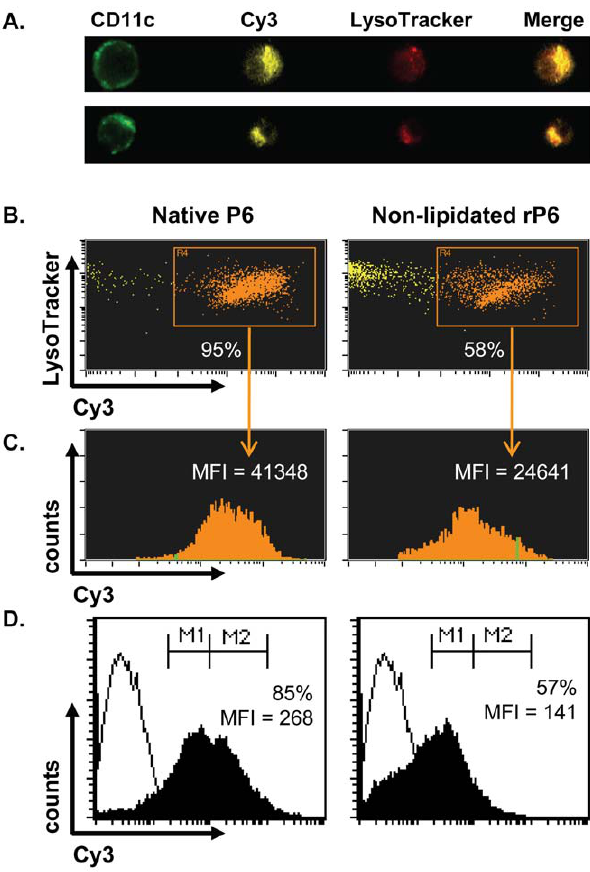
Figure 5. Enhanced endocytosis of lipid-expressing P6 by BMDCs. BMDCs from WT mice were incubated overnight with Cy3- conjugated native P6 or non-lipidated rP6. Cells were incubated with 100 m M LysoTracker Red for 30 min prior to harvest and then stained with anti-CD11c FITC. ( A ) Representative image analysis of Cy3- conjugated endocytosis andco-localization with LysoTracker forbacterial P6 (top row) and non-lipidated rP6 (bottom row). ( B ) Percent of CD11c + BMDCs that endocytosed Cy3-conjugated antigen and co-localize with LysoTracker. ( C ) Amount of endocytosed antigen present in Cy3 + cells as determined by Cy3 mean fluorescent intensity (MFI). ( D ) Antigen uptake by BMDCs determined by two-color flowcytometry (FITC vs Cy3). Percent of CD11c + cells that have endocytosed Cy3-conjugated antigen over unstimulated BMDCs are provided in each plot, in addition to MFI.